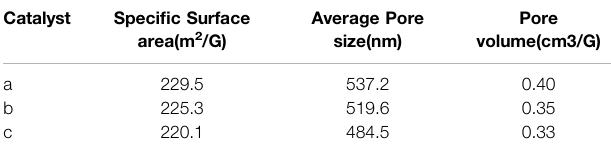
TABLE 2 | Surface characteristics of Fe based composite catalyst. Catalyst